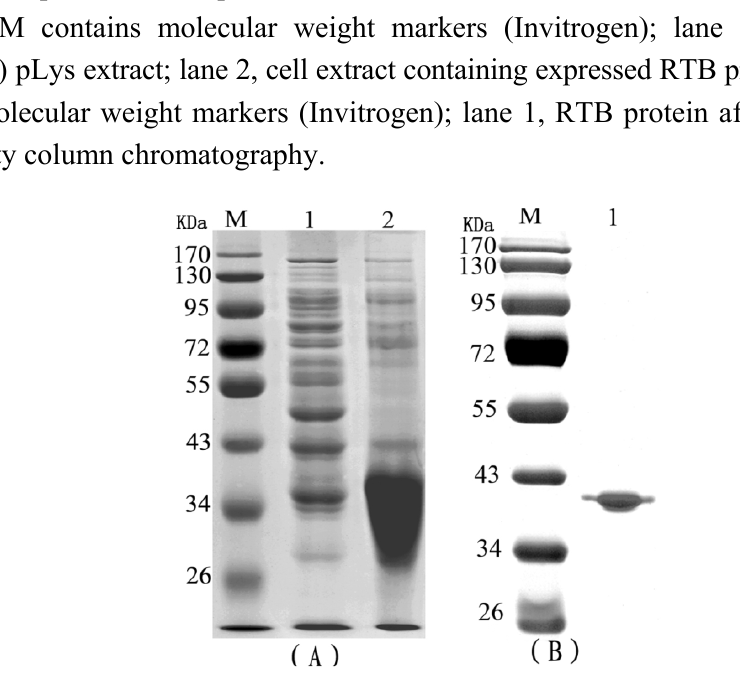
Figure 1. Expression and purification of recombinant ricin toxin B subunit (RTB).